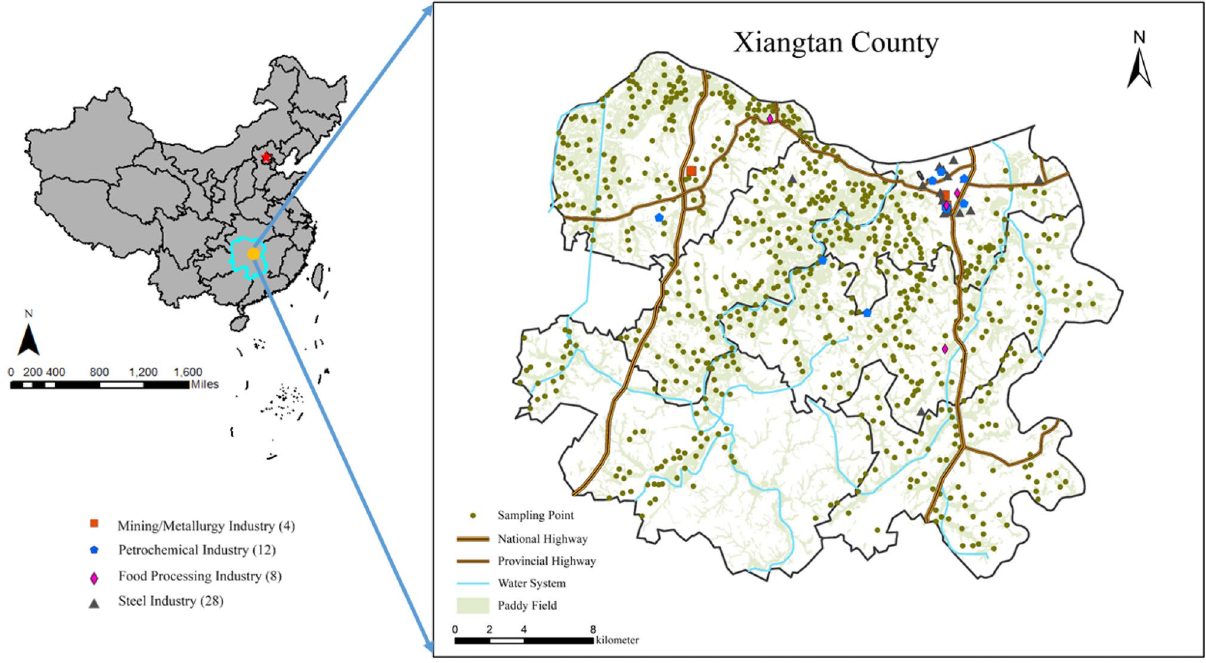
Figure 1. Spatial distribution of monitoring sites in the study area. Pictures were generated by ArcGIS software 10.3; ArcGIS